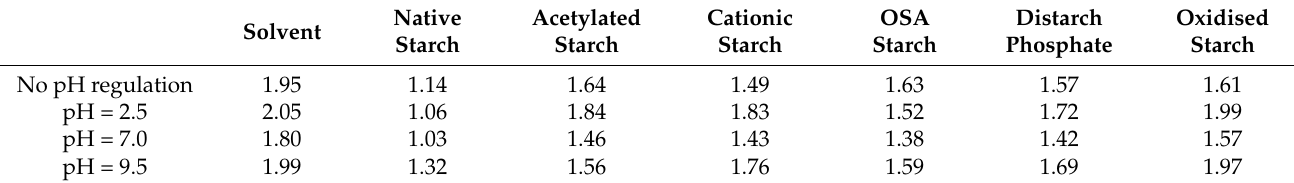
Table 3. Spin-spin relaxation time T 2 values [s] for the analysed starch